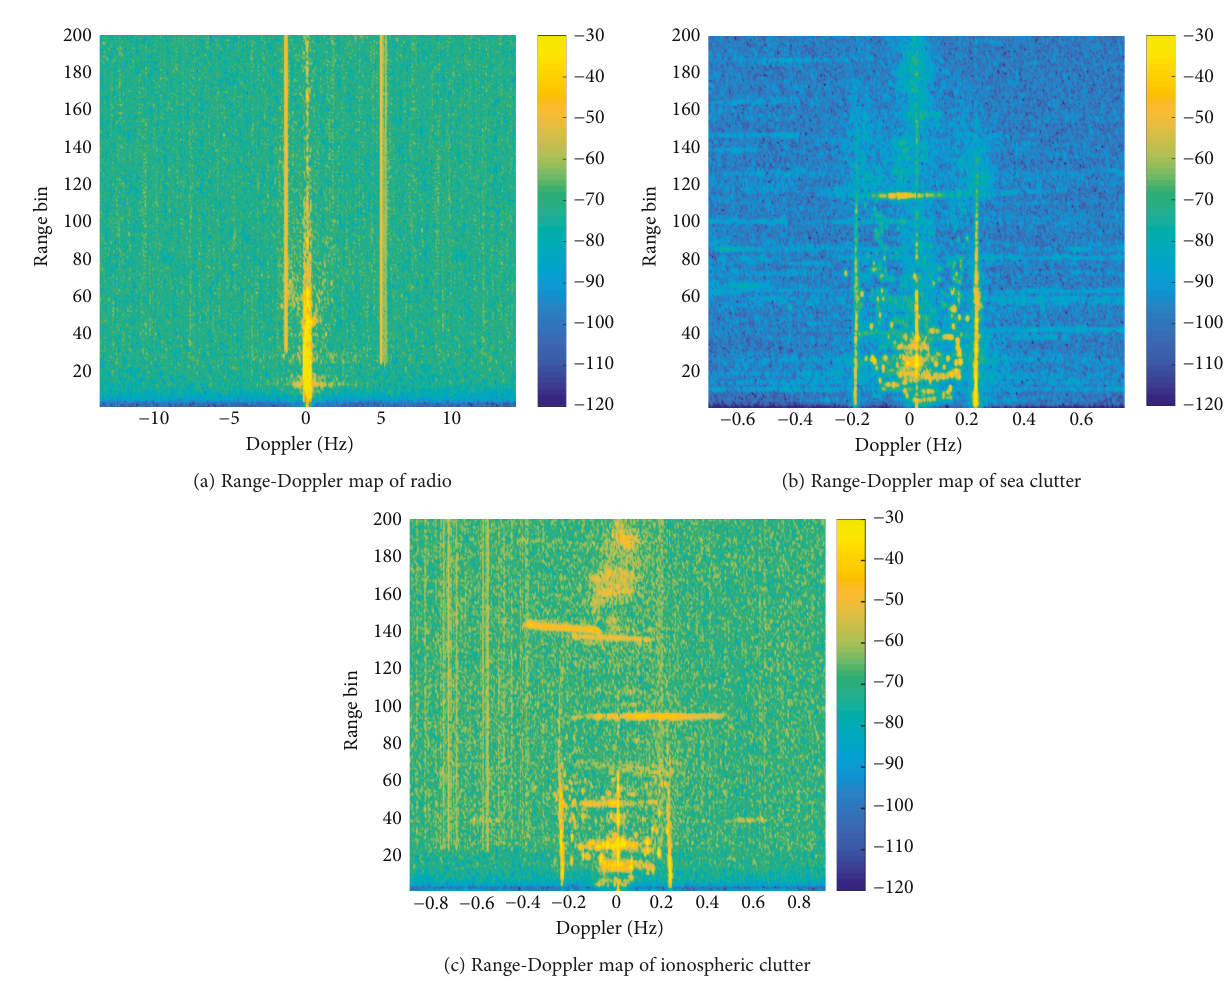
Figure 3: Range-Doppler map with measured